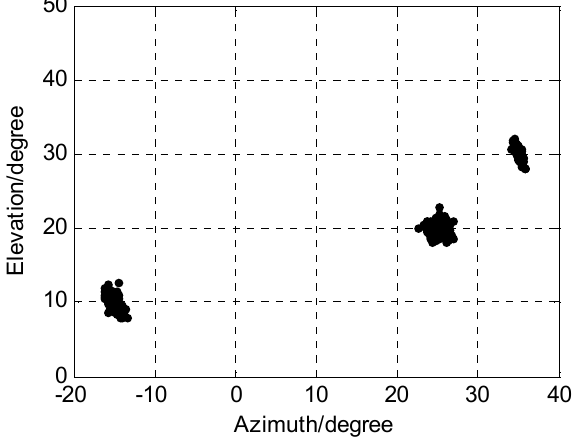
Figure 4. Angle estimation of our algorithm in SNR = 5 dB ( M = 12, J = 100, and K = 3).